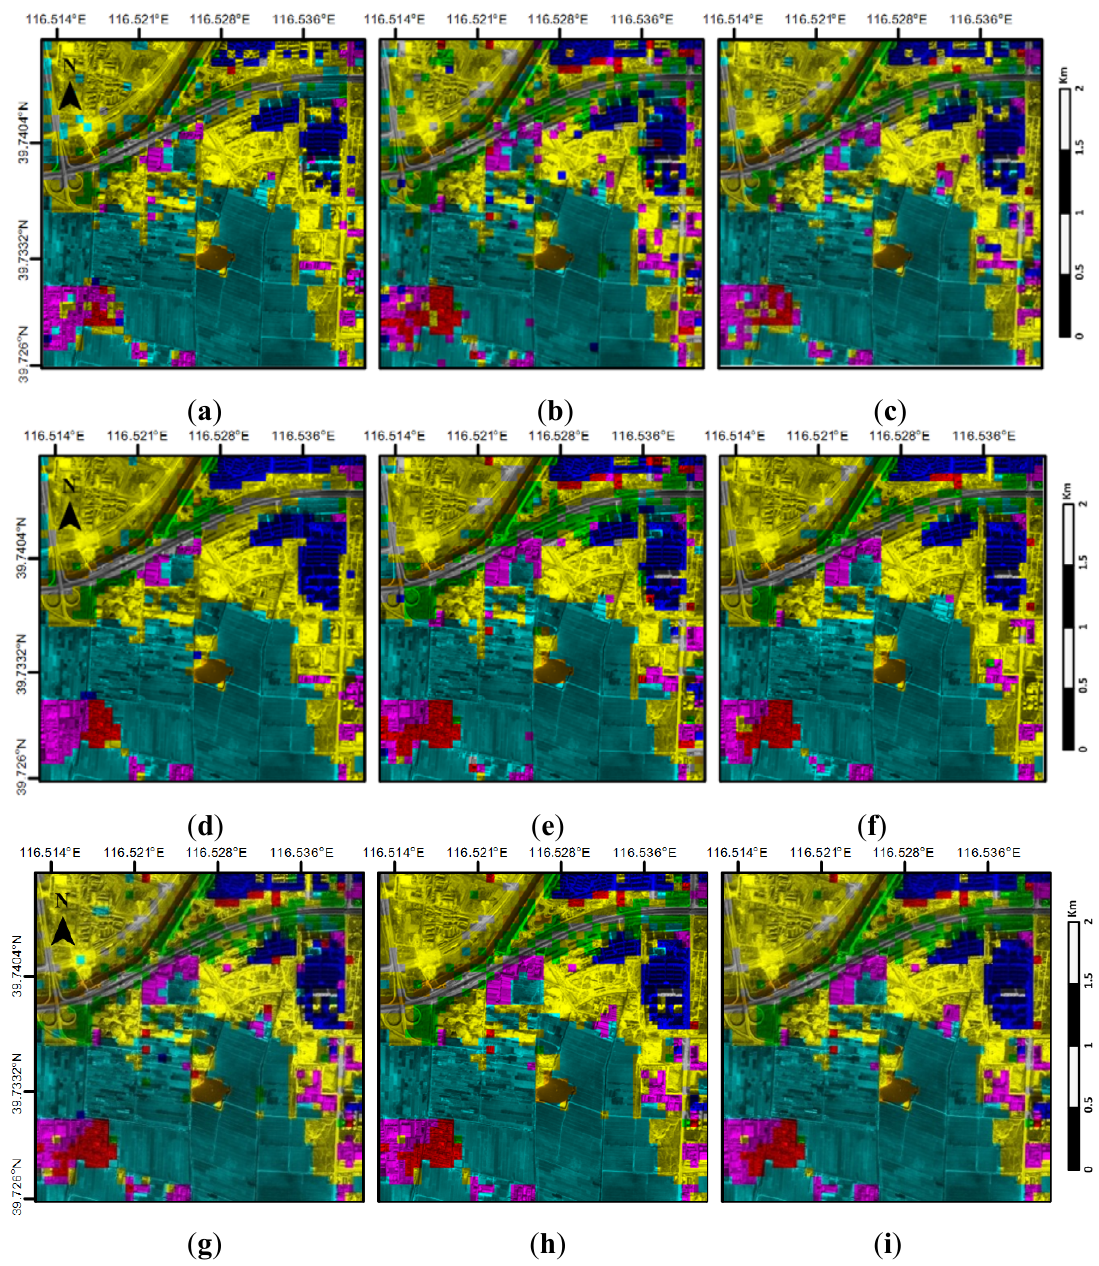
Figure 10. The annotation results of different methods for image II (number of topic is fixed to 35). ( a ) PLSA. ( b ) LDA. ( c ) MedLDA. ( d ) PLSA+CRF. ( e ) LDA+CRF. ( f )